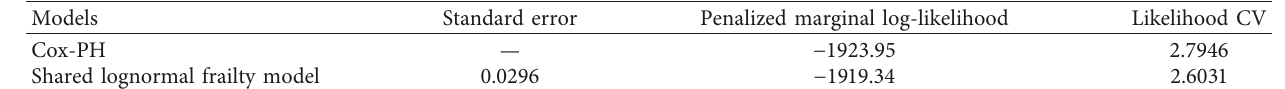
Table 3: Comparison of Cox-PH and shared lognormal frailty models.